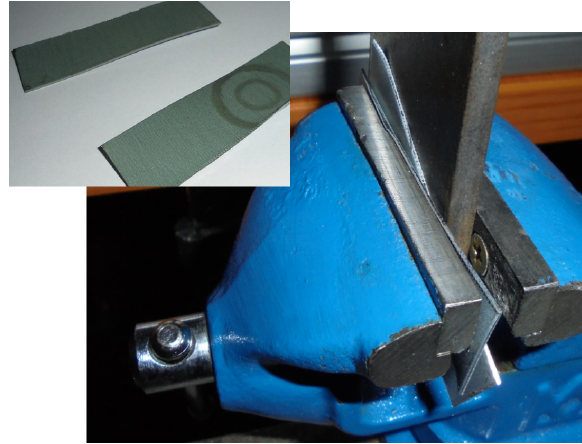
Figure 8: Arrangement of the third experiment, attachment of the bolsters.